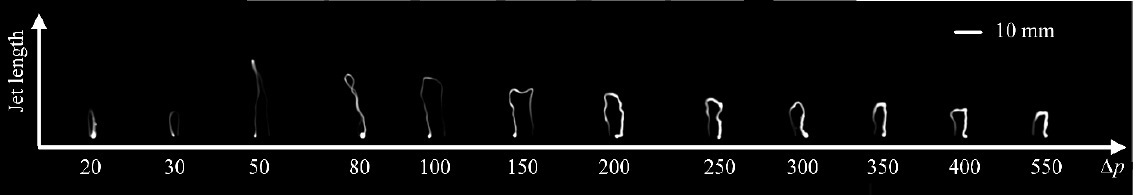
Figure 11. The relationship between jet length and ∆ p .